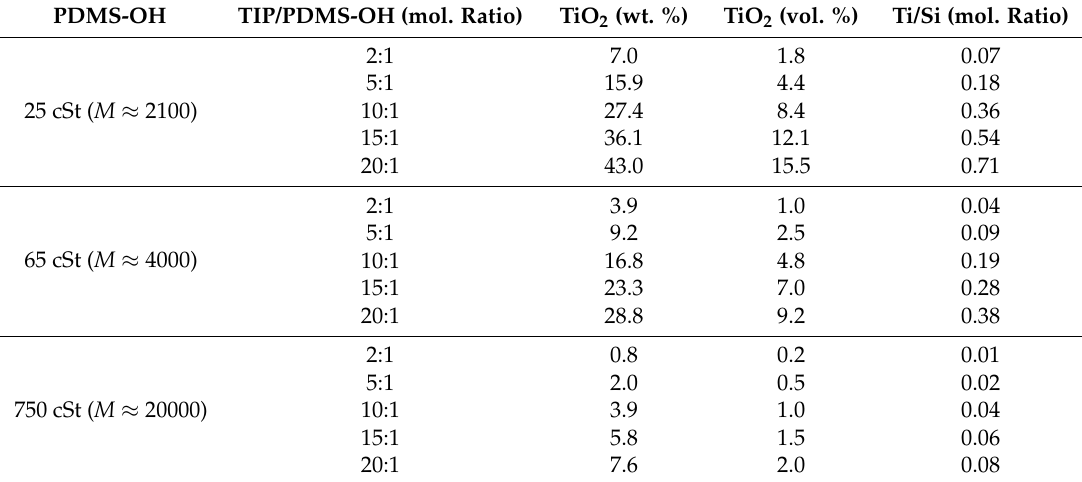
Table 3. Calculated weight and volume contents of TiO 2 and Ti/Si atomic ratios of the Ti-PDMS hybrids, assuming full reaction of TIP to